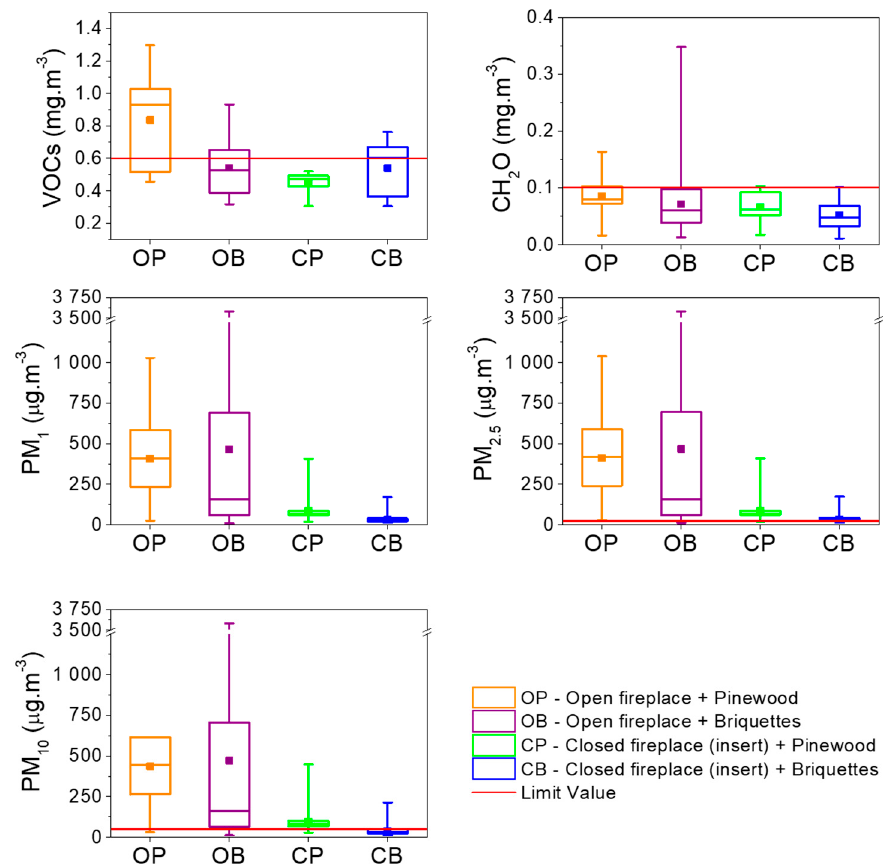
Figure 5. Indoor air pollutants and comfort parameters during the four combustion scenarios (OP—Open fireplace + Pine, OB—Open fireplace + Briquettes, CP—Closed fireplace (insert) + Pine, CB—Closed fireplace (insert) + Briquettes). The box plot represents mean (square) and the quartiles (5%, 25%, median, 75% and 95%).